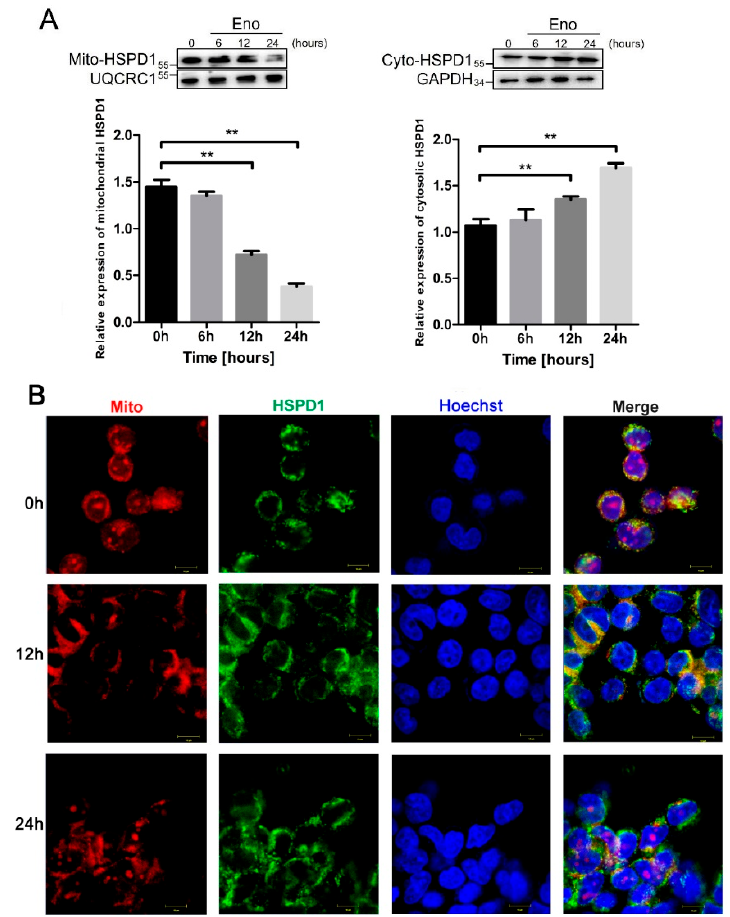
Figure 3. HSPD1 translocates from mitochondria into the cytoplasm after Eno treatment. 293T cells were treated with Eno and incubated for 0 h, 6 h, 12 h, and 24 h at 37 °C . ( A ) Western blotting was used to determine the expression of HSPD1 in protein fractions derived from mitochondrial and cytoplasmic compartments at different time points after Eno treatment. UQCRQ1 and GAPDH were selected as the housekeeping proteins. ( B ) Immunofluorescence to determine the localization of HSPD1 and mitochondria at different time points after Eno treatment. (Scale bar, 10 µ m) (**, p <